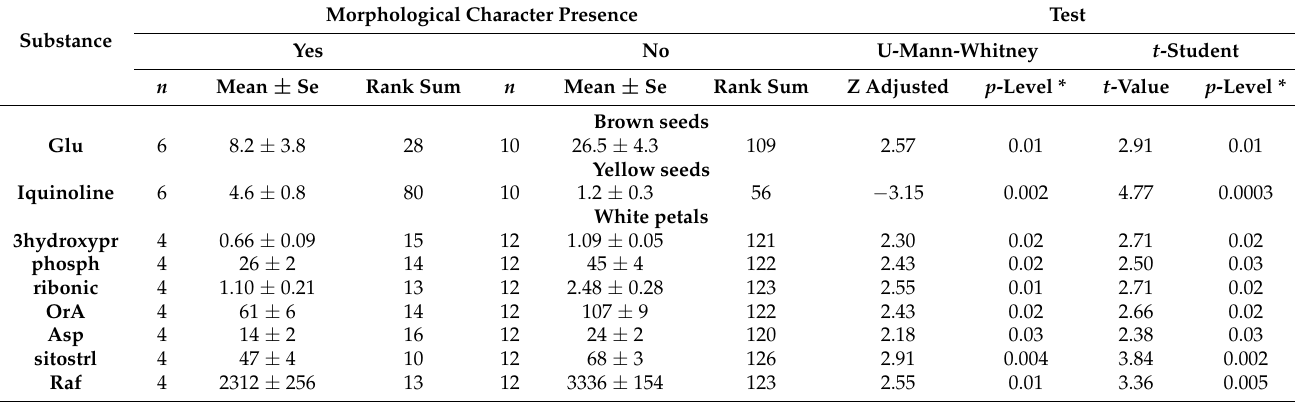
Table 2. Comparison of the substances content in flax lines differing in morphological characteristics according to the criteria of U-Mann-Whitney and t -Student. *—differences between alternative groups by the analyzed parameter are significant at p <